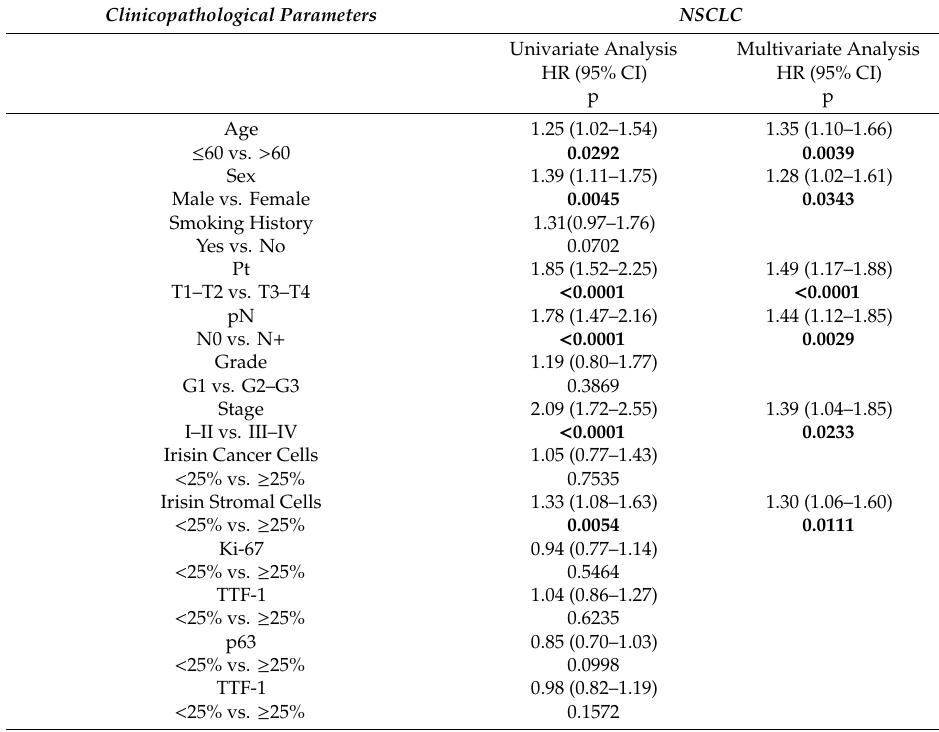
Table 3. Univariate and multivariate Cox proportional hazards analysis in 729 patients with